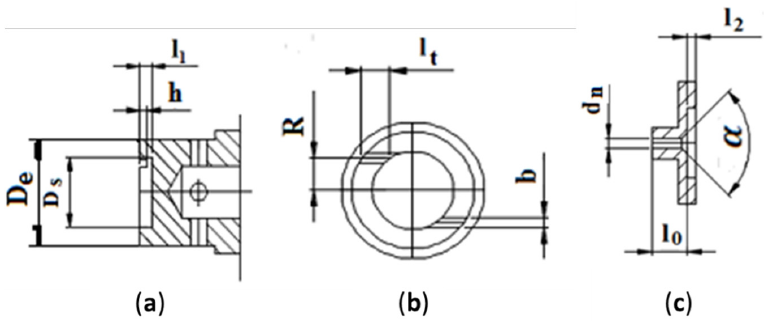
Figure 3. The geometrical parameters of a pressure swirl atomizer: ( a ) swirl chamber of a mechanical atomizer, ( b ) front view of the swirl chamber, ( c ) nozzle of the swirl chamber.